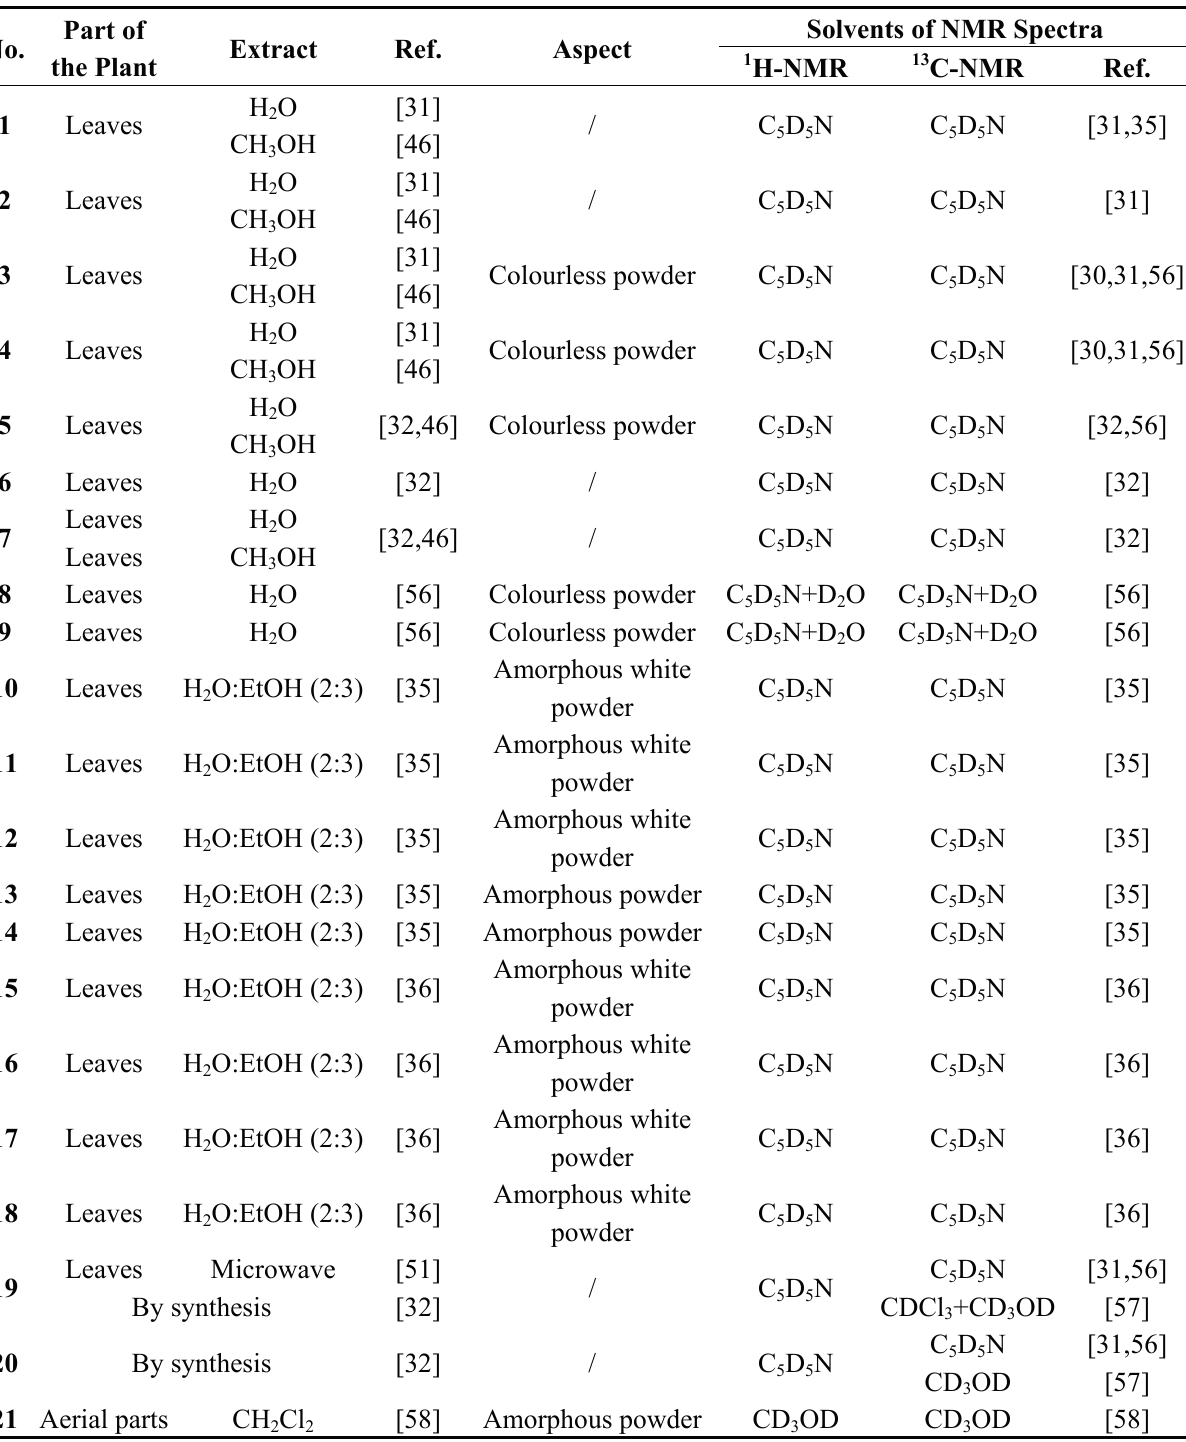
Table 2. Isolation and distribution of triterpenes in the different parts of the plants and their NMR spectral data.